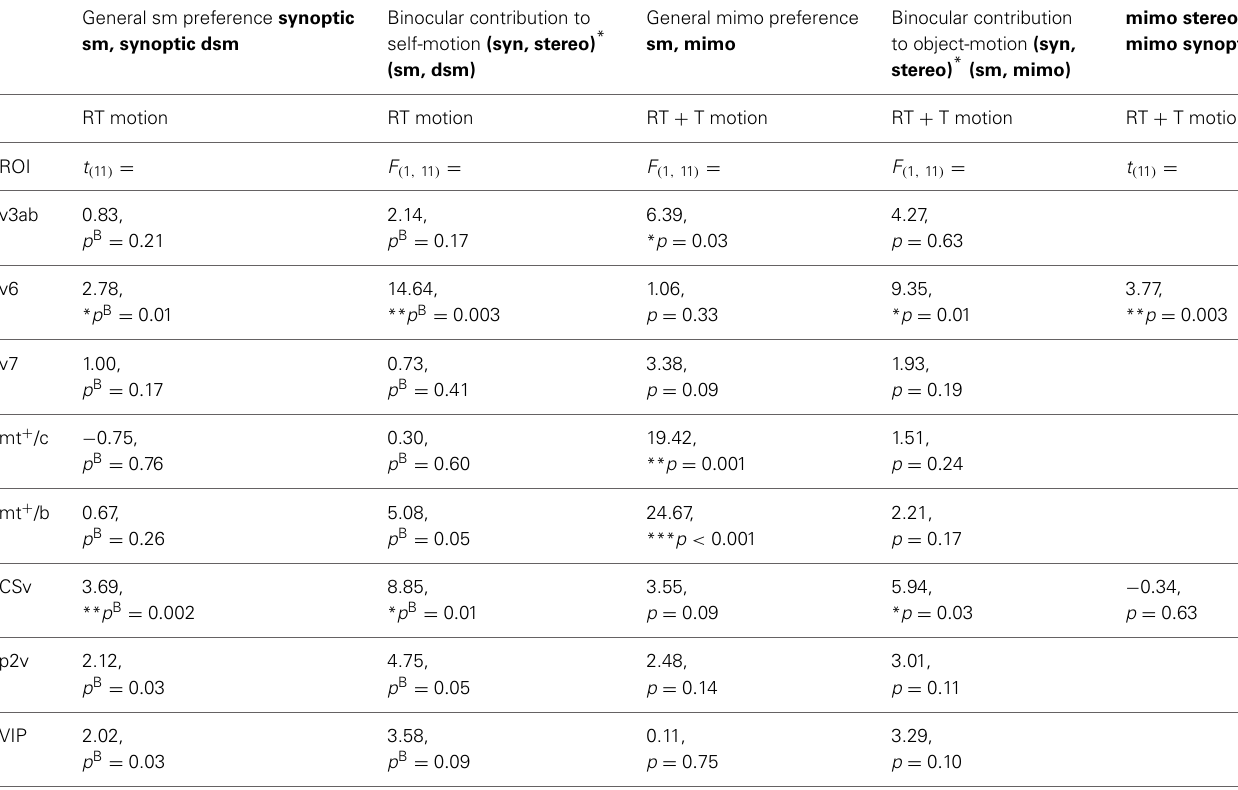
Table 2 | Overview of the primary effects tested and the F , or t statistics for the different ROIs. General sm preference